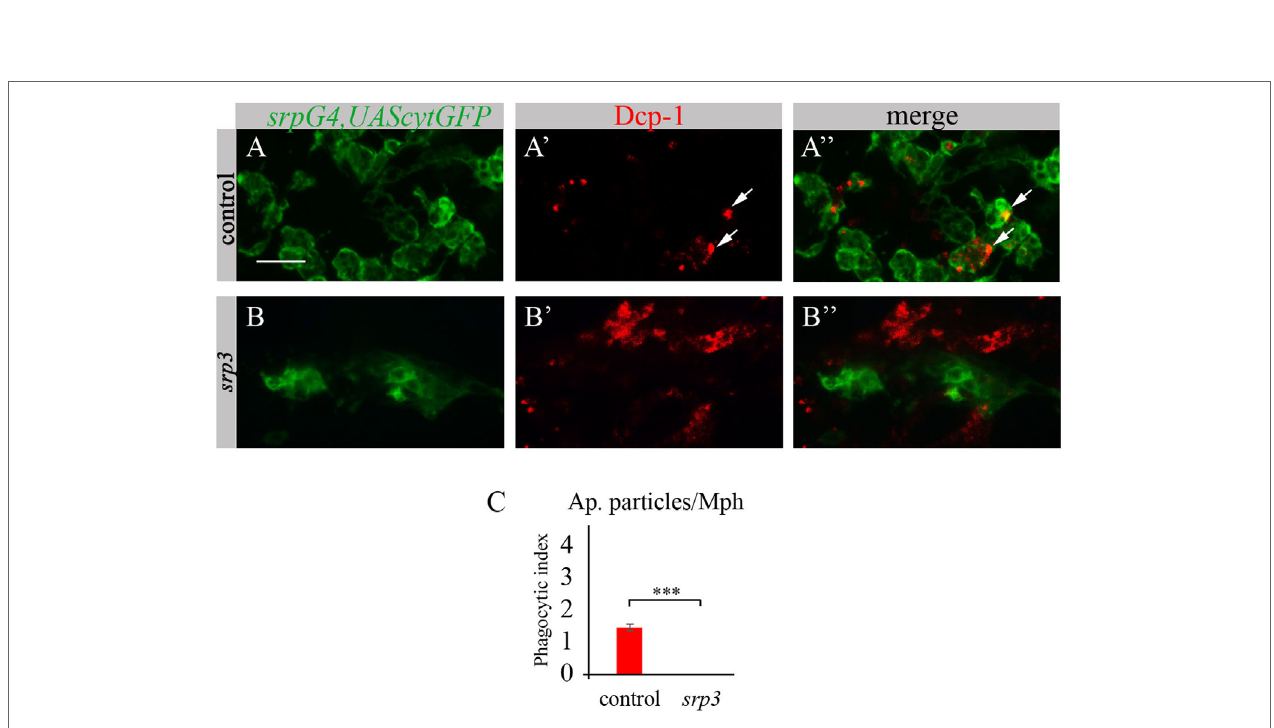
FigUre 2 | SIMU is not expressed in srp mutant macrophages. (a–D’’) Projections from confocal stacks of the stage 16 embryos, lateral view. Macrophages are labeled with srpGal4,UAScytGFP (green). Anti-SIMU in red. Glial nuclei are labeled with anti-REPO (blue). (a–B’’) Control srpGal4,UAScytGFP embryo. (c–D’’) srpGal4,UAScytGFP ; srp 3 mutant embryo. (B–B’’,D–D’’) Close up of rectangle areas in (a’’’,c’’’) respectively. All GFP-positive macrophages express SIMU on their membranes in control embryo [ (B,B’’ ), arrows] but no one expresses SIMU in srp mutant embryo [ (D,D’’) , arrows]. Note SIMU expression in glia (non GFP-positive cells, arrowheads). Bar, 20 µm. (e) Columns represent mean diameter of 10 macrophages in each embryo ± SEM. Control embryos ( n = 5). srp 3 mutant embryos ( n = 7). Asterisks indicate statistical significance versus control, as determined by Student’s t -test, *** p <